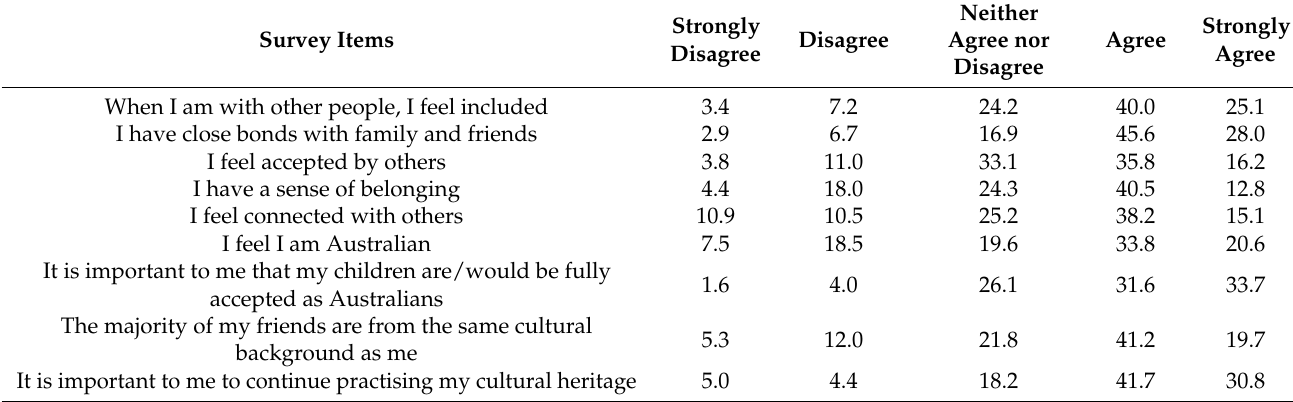
Table 5. Sense of belonging for Asian Australians who experienced online racism during the COVID- 19 pandemic (%), n =